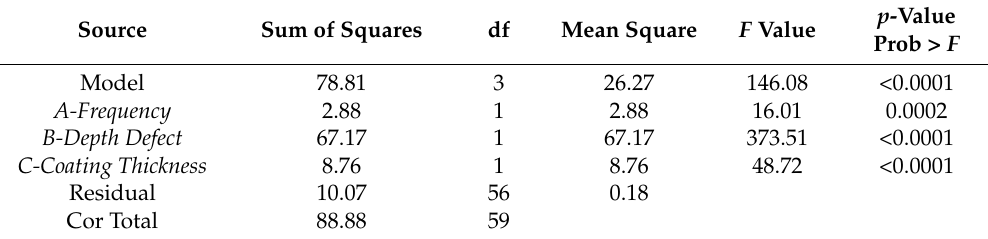
Table 5. Response Output Peak.